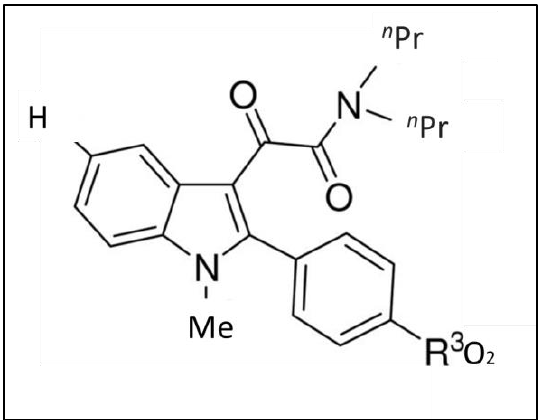
Figure 7. Chemical structure of N1-methylated derivative N,N-di-n-propyl-(N1-methyl-2-(4’-nitrophenyl)indol-3-yl)glyoxylamide (ligand 31).